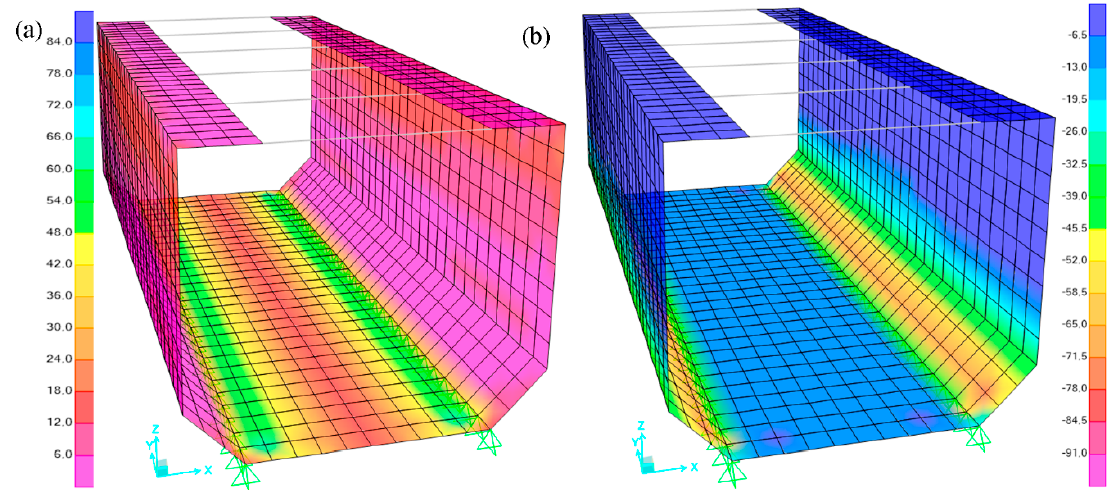
dmax and ( b ) V dmin